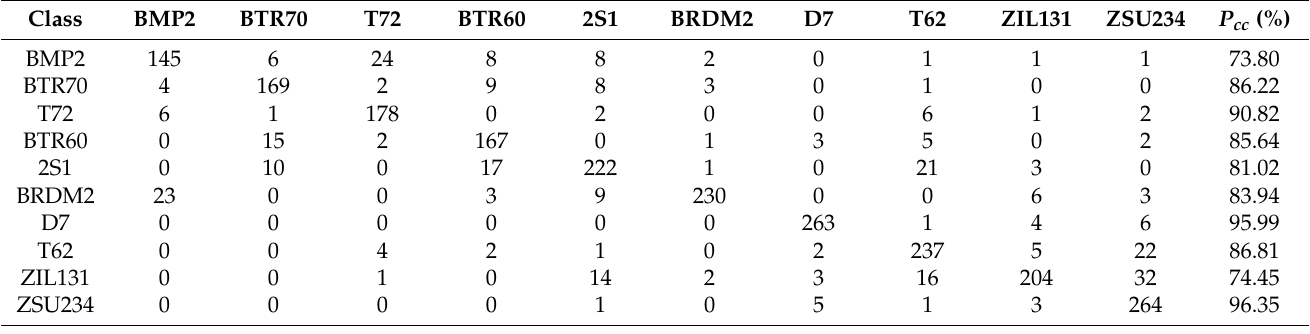
Table 3. Confusion matrix of the recognition result from the basic CNN related to Table 2.